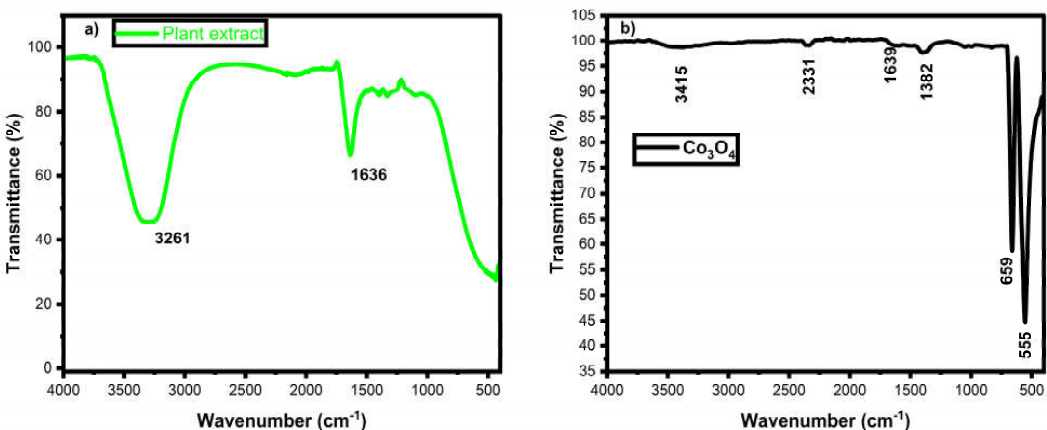
Figure 2. FTIR spectrum of C. longa (a) and Co 3 O 4 nanoparticles (b).